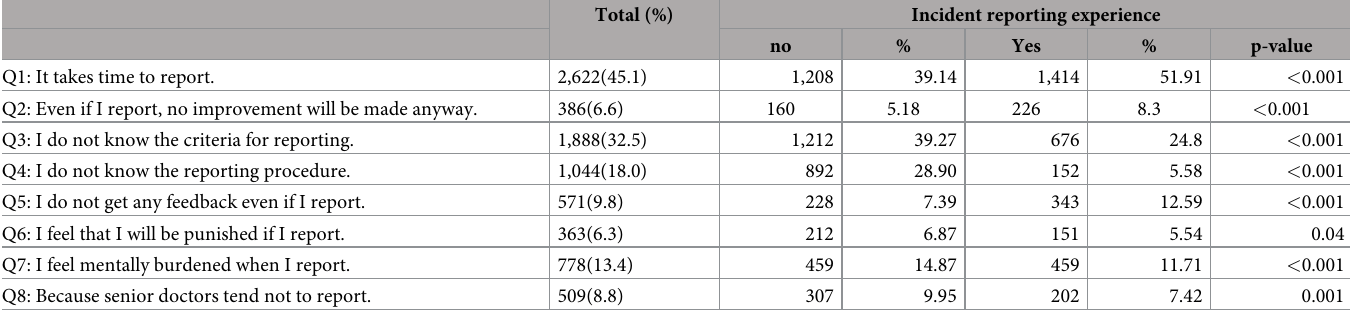
Table 3. Barriers to incident reporting.